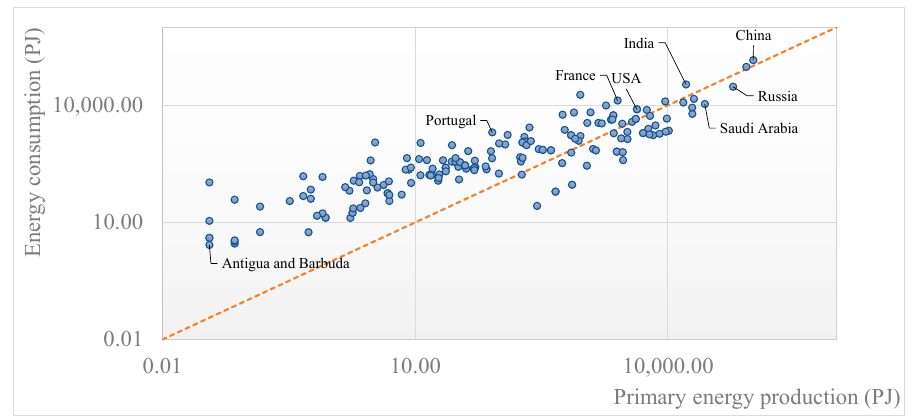
Land 2023 , 12 , 669 Figure 3. Production of primary energy vs. energy consumption in di ff erent countries (2019). Figure 3. Production of primary energy vs. energy consumption in different countries (2019).